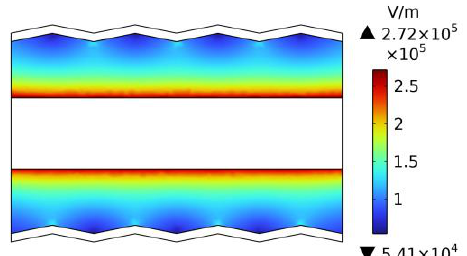
Figure 4. Distribution of the electric field in the lengthwise cross-section of the cable insulation.